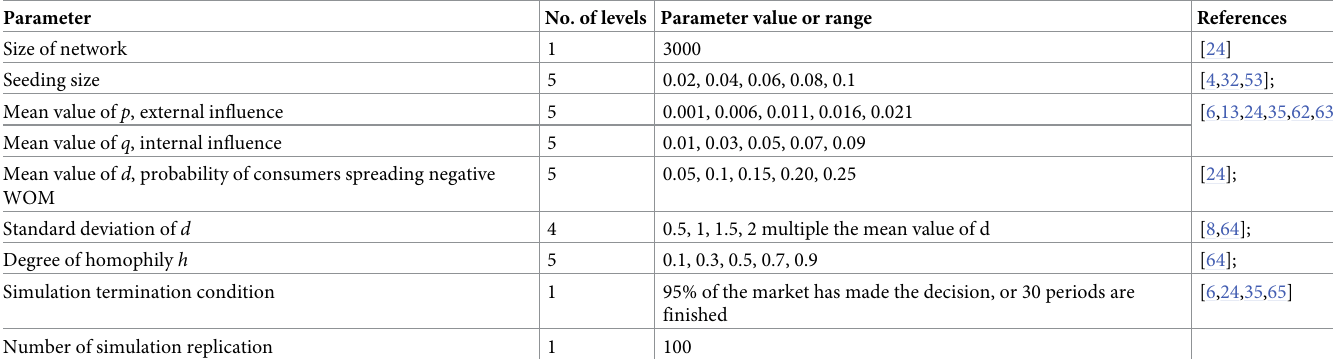
Table 2. Parameters and their corresponding